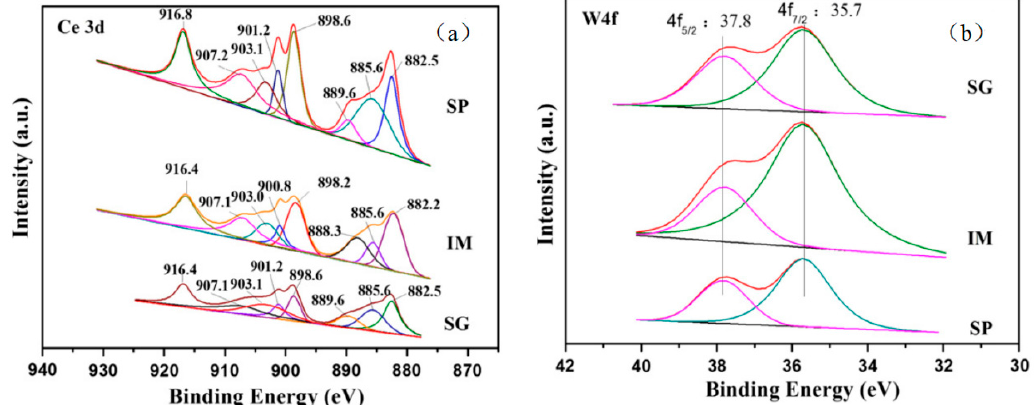
Figure 9. XPS spectra of ( a ) Ce3d and ( b ) W4f over CeO 2 –WO 3 catalysts